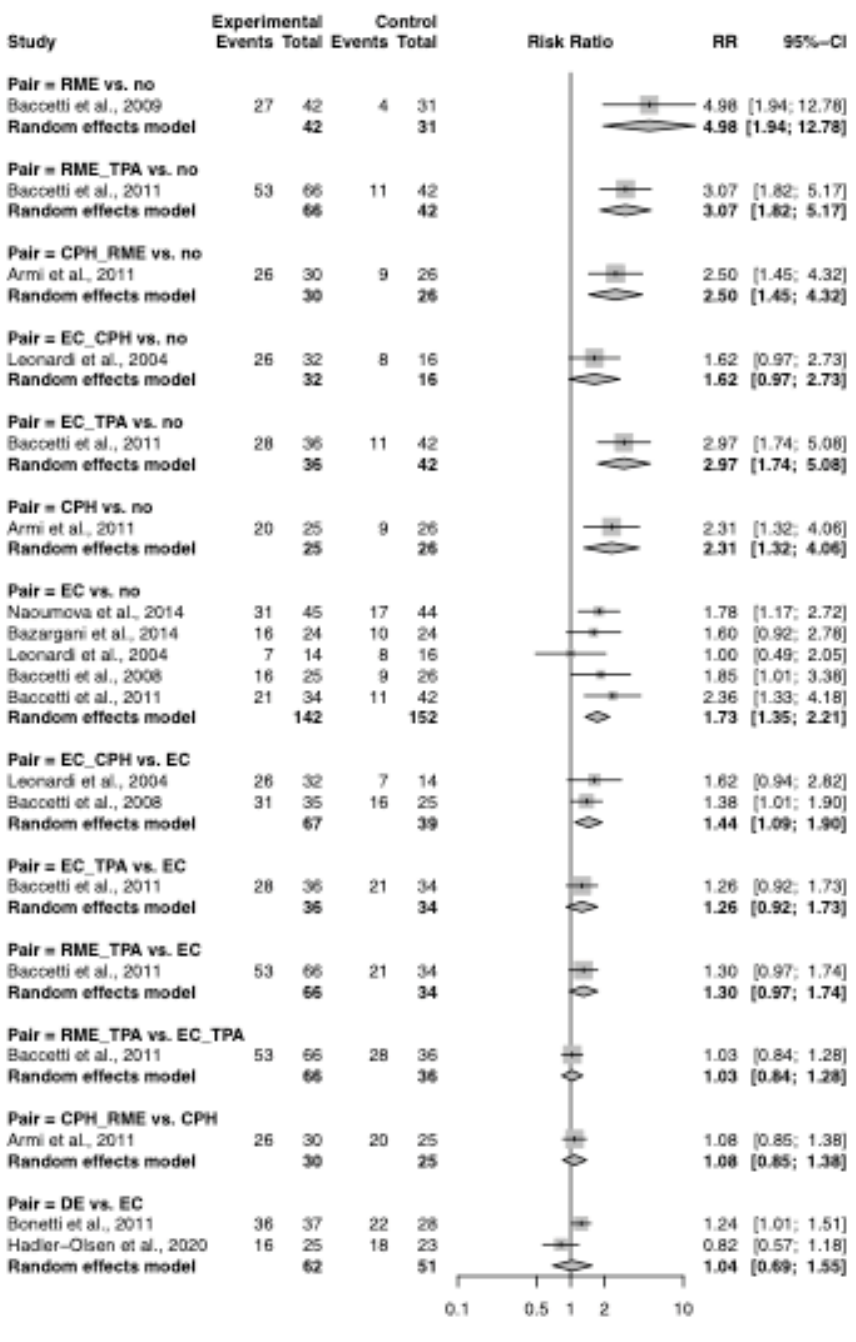
Figure 3. Forest plot of the traditional pairwise